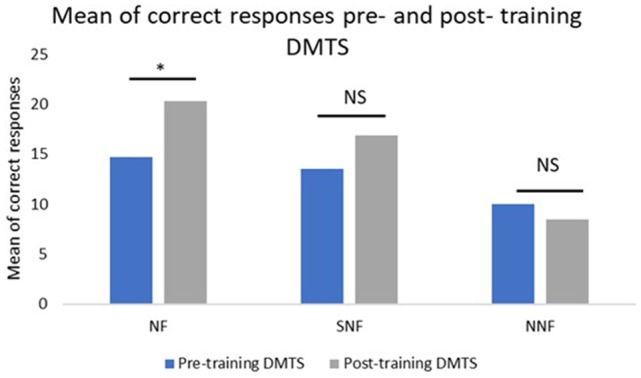
Mean number of correct responses pre- and post-training, where the NF group showed a significant difference between the conditions, while the SNF, although increasing their performance, had no statistically significant difference between conditions. The no neurofeedback training (NNF) had no changes in their performance. *Significant difference; NS, not significant.